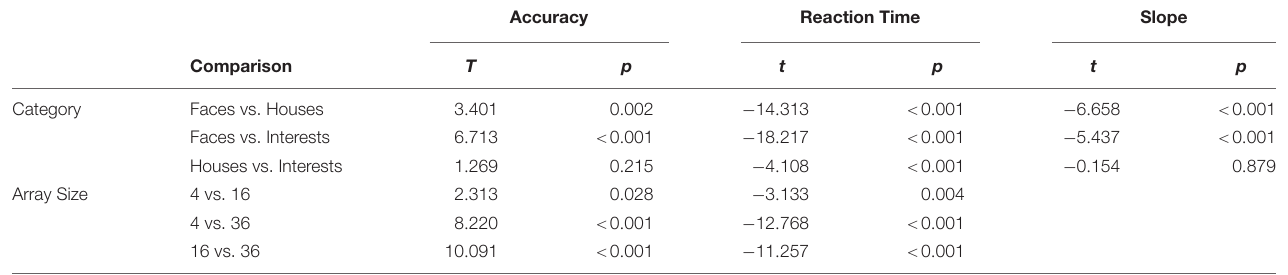
TABLE 2B | Category task statistics ( Post hoc analyses).